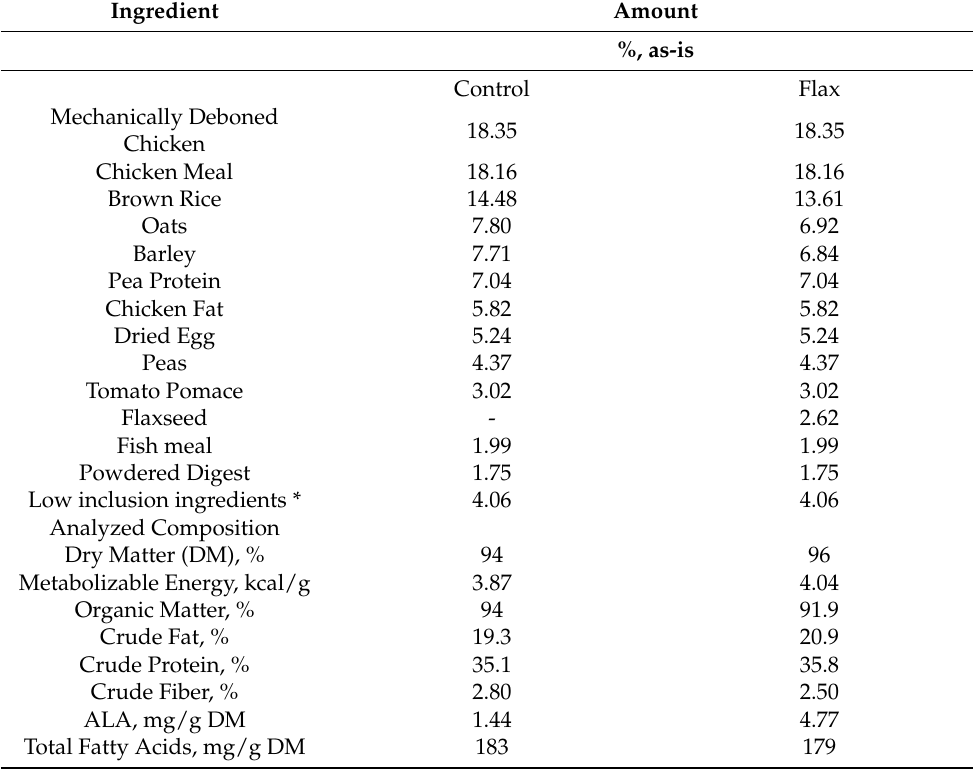
Table 1. Ingredient and chemical composition of experimental diets (Control and